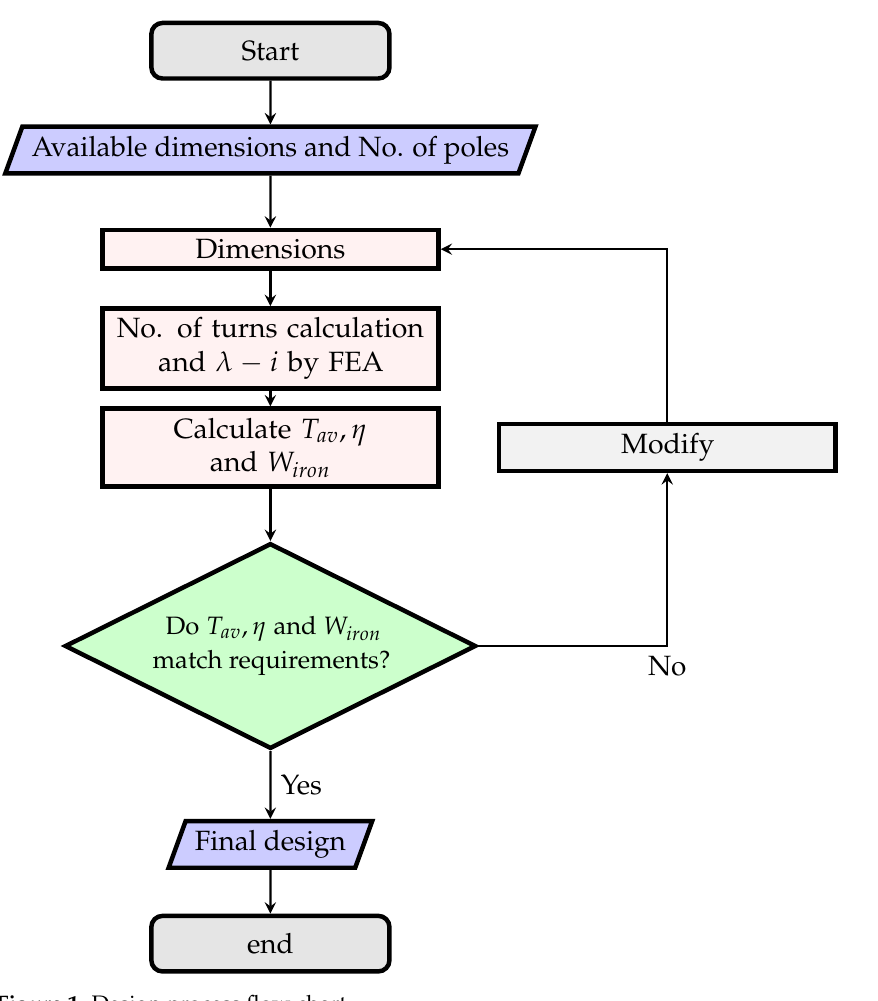
Figure 1. Design process flow